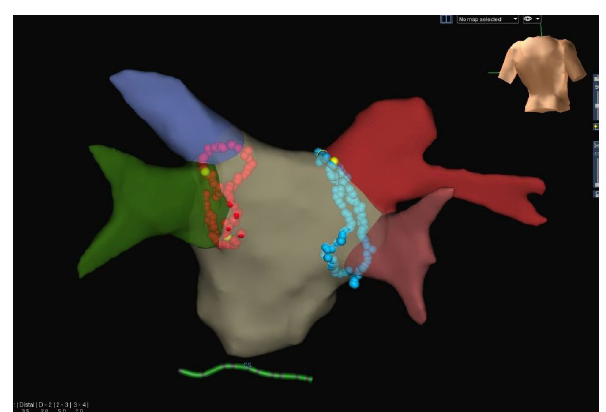
Fig. 1. Manual navigation-guided catheter ablation. 3D electro-anatomical map of the left atrium during ablation of paroxysmal atrial fibrillation using system EnSite Velocity from postero-anterior view. Red and blue dots highlight circular radiofrequency ablation lesions around the left and right pul- monary veins respectively. Yellow dots are places of isolation of the pulmonary veins.